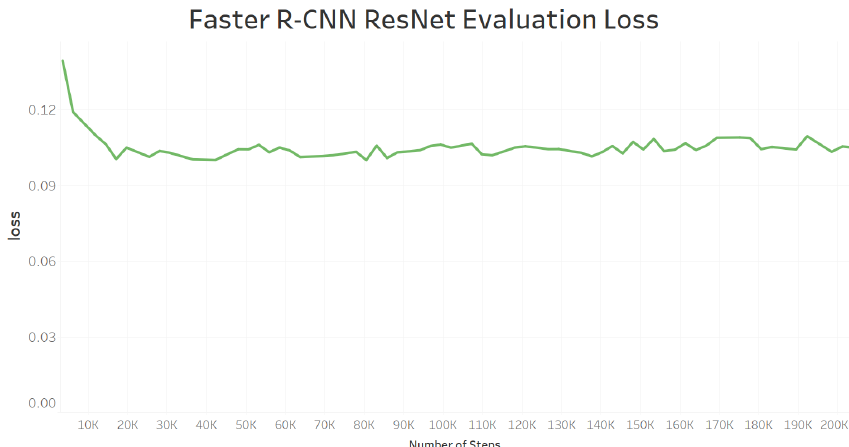
Figure 13. The evaluation loss is around 0.1 for Faster R-CNN. There is clearly no over-fitting as the training loss and the evaluation loss values are